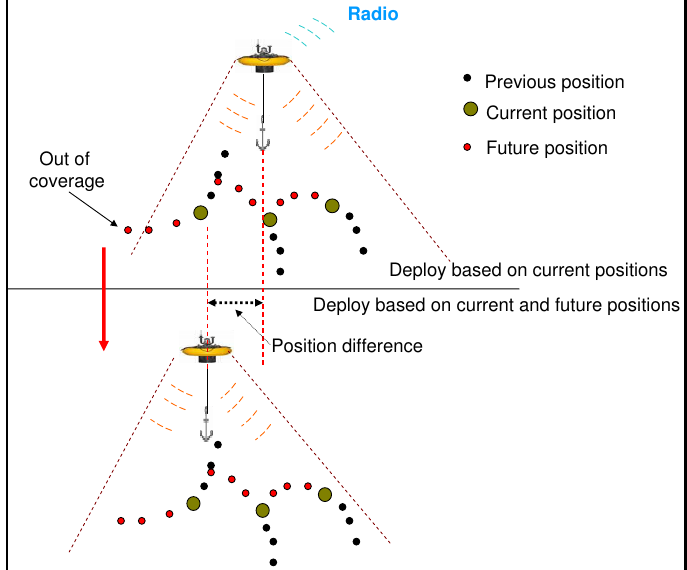
Figure 3. Naive deployment ( top ) predictive deployment ( bottom